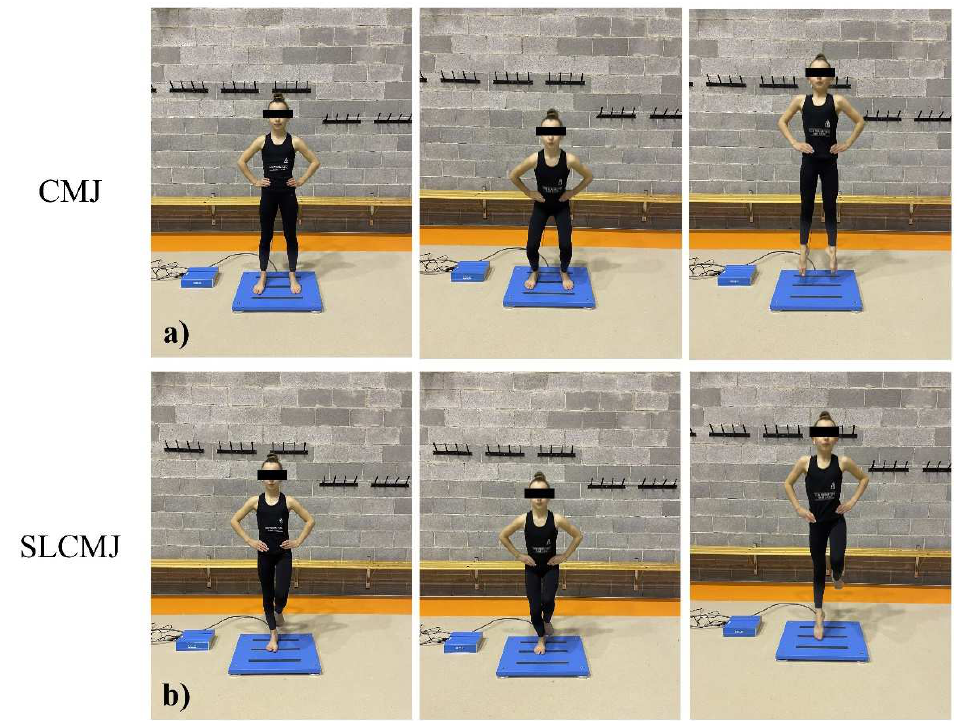
Figure 2. ( a ) CMJ test and ( b ) SLCMJ test. From a standing position, gymnasts performed an SSC fast movement to